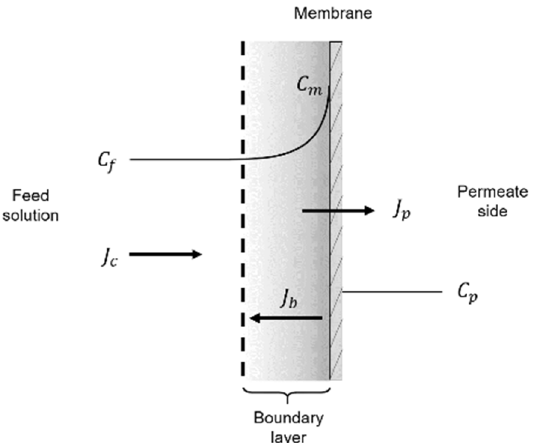
Figure 3. Schematic representation of the concentration polarization phenomenon. C f , C m and C p , respectively, represent foulant concentration in the feed bulk, at the membrane surface and in the permeate stream, whereas J c , J p and J b indicate the convective flux toward the membrane, the permeate flux and the diffusive black flux determined by the concentration difference between the membrane surface and the feed bulk.